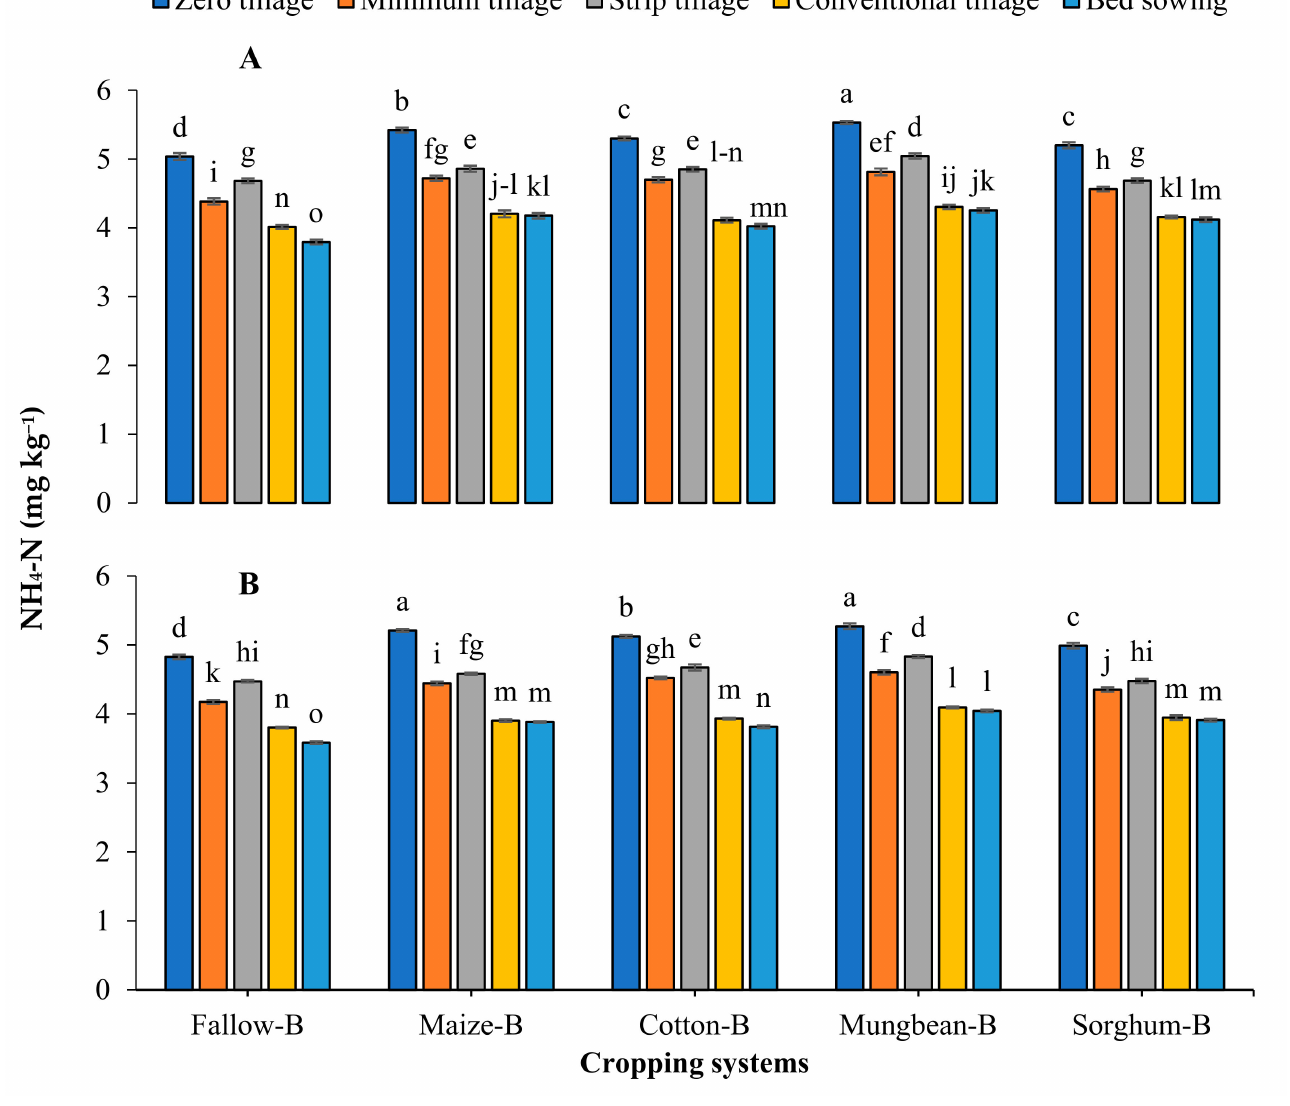
Figure 1. Interactive effect of tillage systems and barley-based cropping on NH4-N (mg kg − 1 ) after barley harvest during 2017–2018 ( A ) and 2018–2019 ( B ) ± S.E. In the legend, Fallow-B = Fallow-barley, Maize-B = Maize-barley, Cotton-B = Cotton-barley, Mungbean-B = Mungbean-barley and Sorghum-B = Sorghum-barley. The means sharing same letters do not differ significantly ( p > 0.05). LSD 0.05 (2017–2018 = 0.10, 2018–2019 =